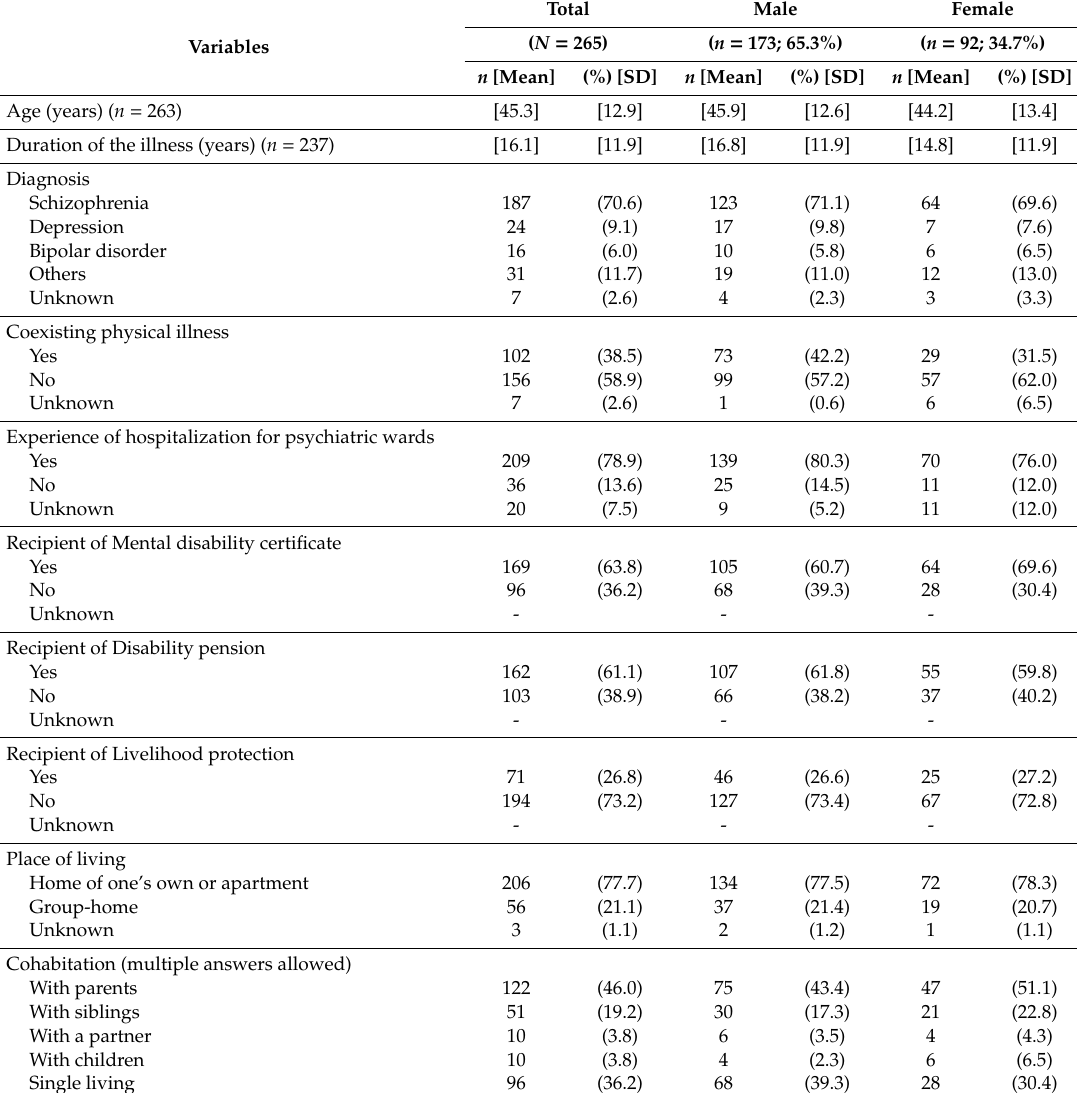
Table 1. Sociodemographic and clinical characteristics of the respondents in the study ( N = 265).